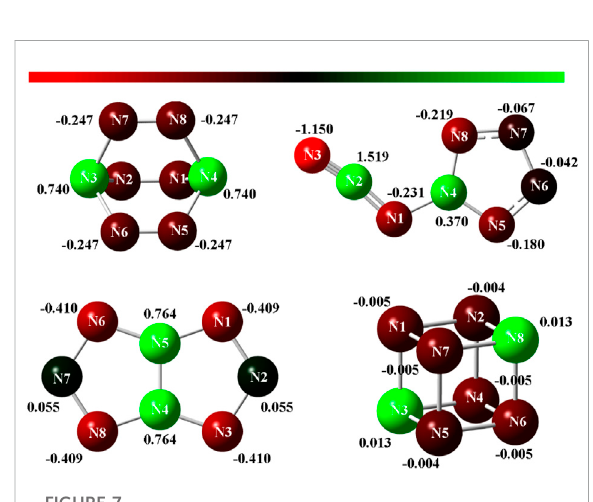
FIGURE 7 Natural bondorbitalchargesof N 4 -1,N 4 -2,N 8 -1,N 8 -2, N 8 -3, and N 8 -4 ,